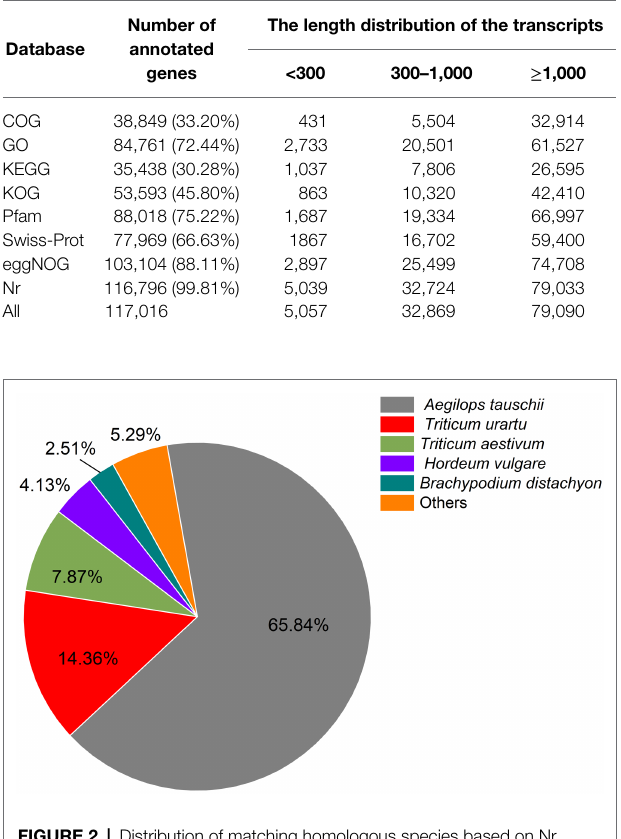
FIGURE 2 | Distribution of matching homologous species based on Nr